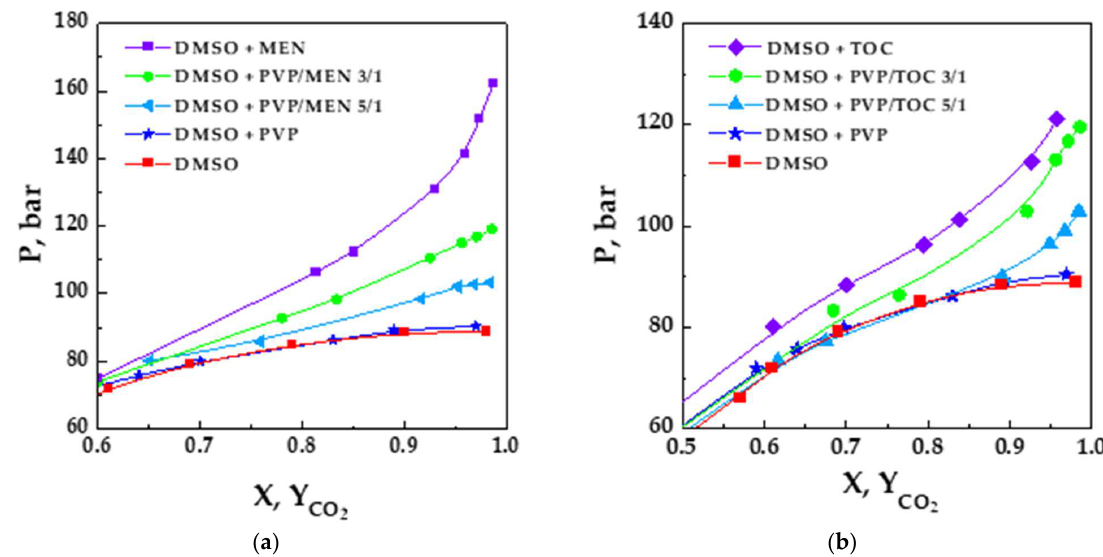
Figure 5. Comparison in a P-x diagram between the DMSO/CO 2 system and the ternary and quaternary systems at a temperature of 313 K for MEN ( a ) and TOC ( b ).